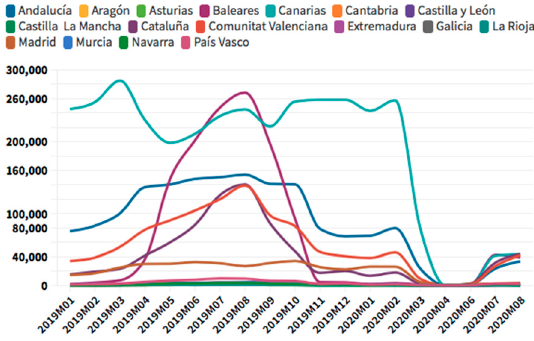
Figure 6. International tourism apartments occupancy. Source: Own elaboration from INE data.